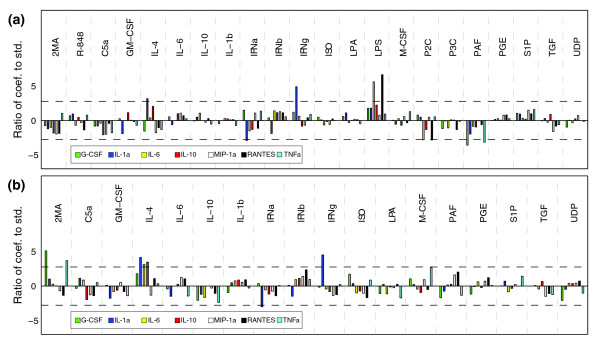
Significance of ligand predictors for cytokine release residuals. Data from TLR ligand stimulation were (a) included or (b) excluded. Residuals of cytokine release measurements were calculated from PCR models using signaling pathways as predictors. PCR analyses were performed on the residuals as described in Materials and methods. Averaged ratios outside a 95% confidence interval after noise correction (horizontal dashed lines) are considered significant. Since these residuals also carry noise, we applied a corrective factor to set a higher confidence interval to identify significant ligands (see Materials and methods).